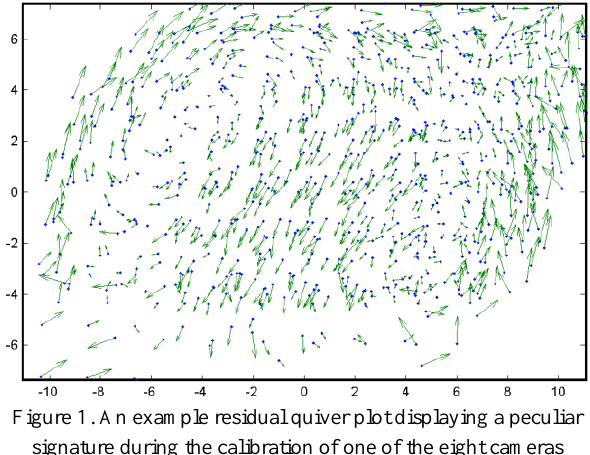
Figure 1. An example residual quiver plot displaying a